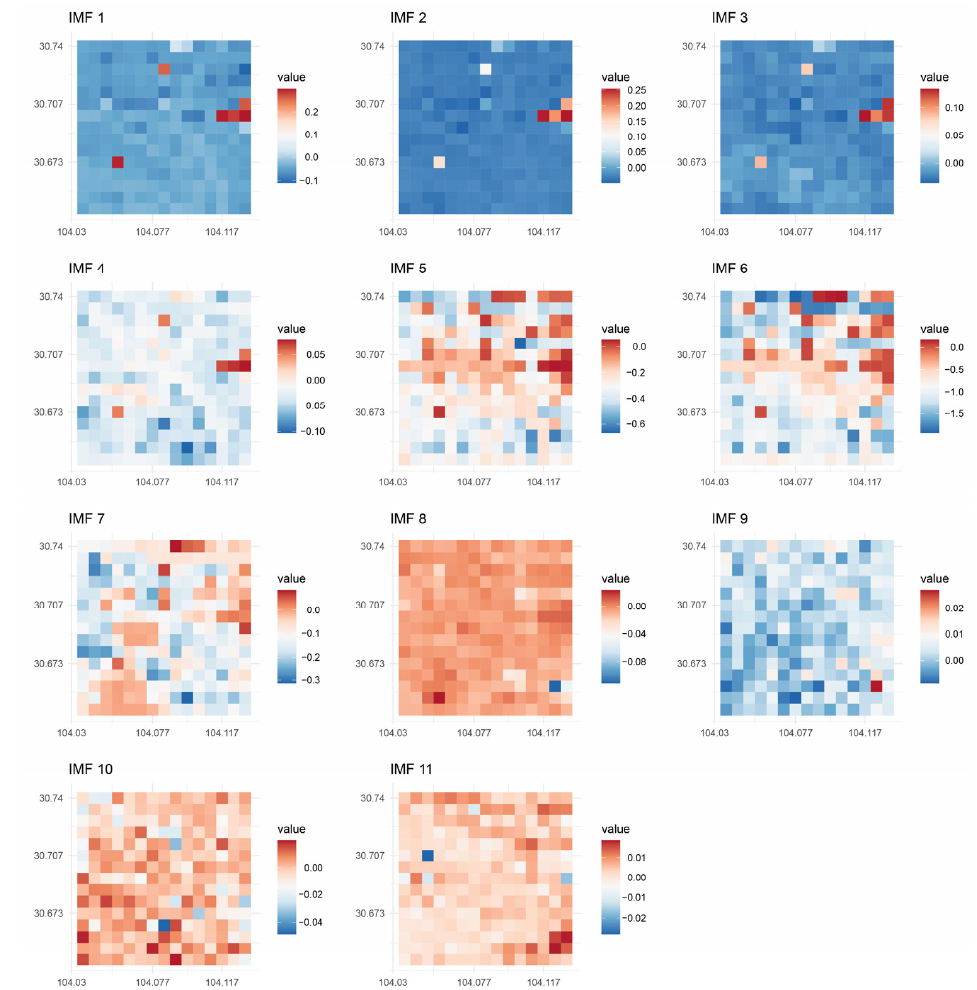
Figure 6. Spatial visualization of contribution. Each grid has a contribution value for each IMF component, which can be combined to construct the contribution